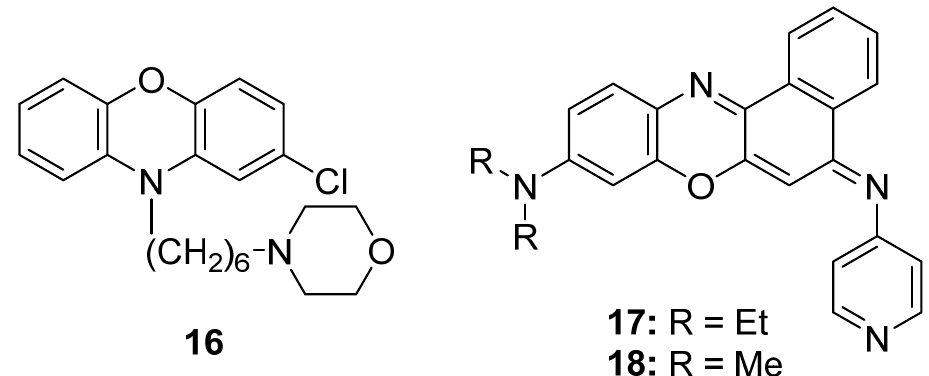
Figure 12. Phenoxazin derivatives with antibacterial ( 16 ) and antimalarial ( 17 and 18 ) activity.